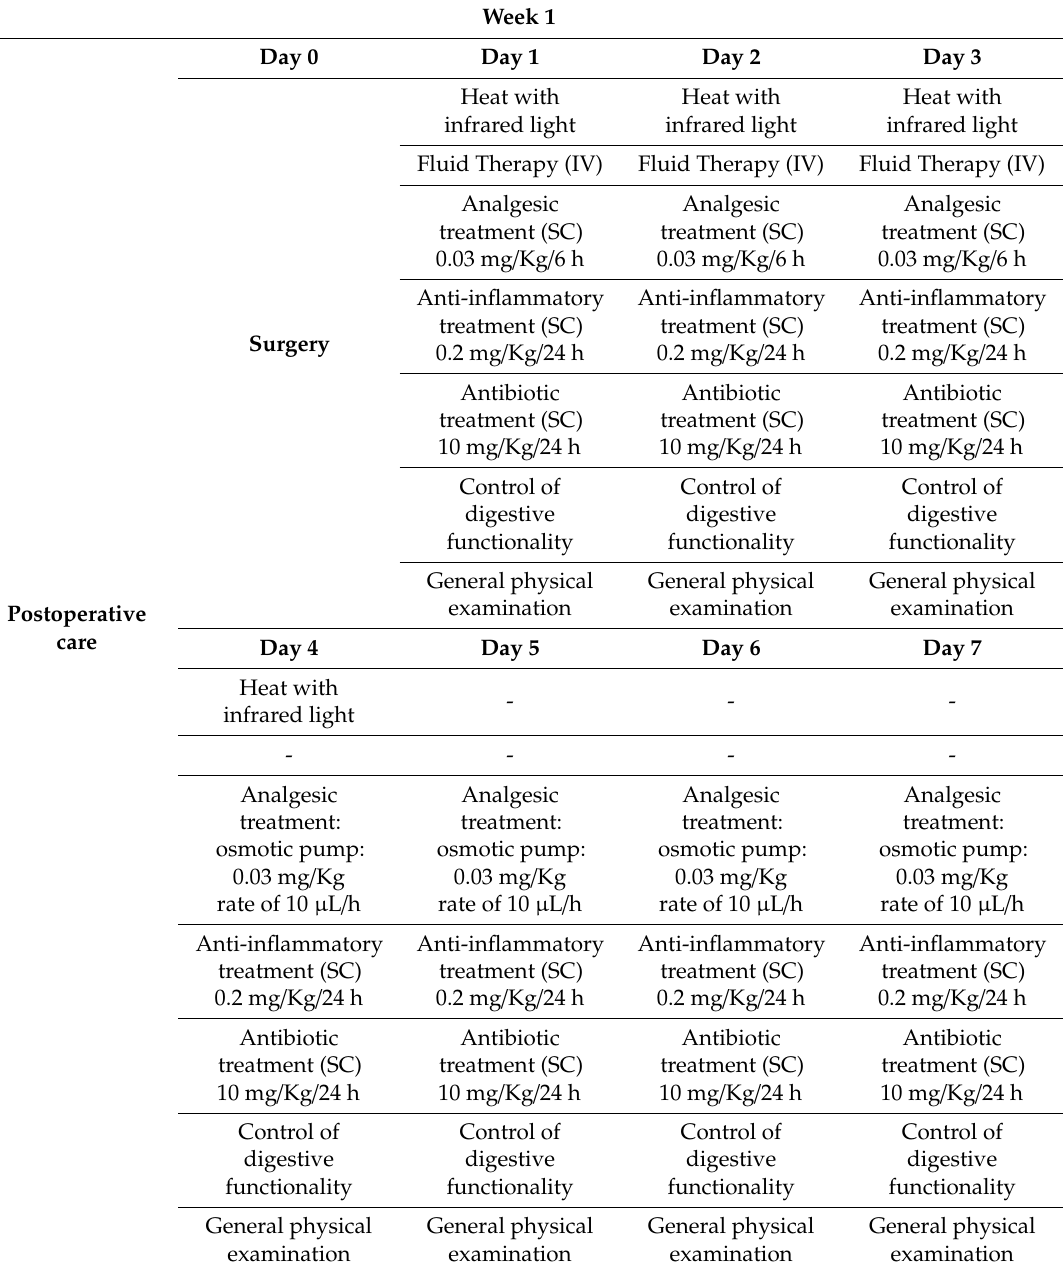
Table 1. Summary of the postoperative care protocol designed and applied during the first week after surgery. Abbreviations: IV, intravenous; SC,